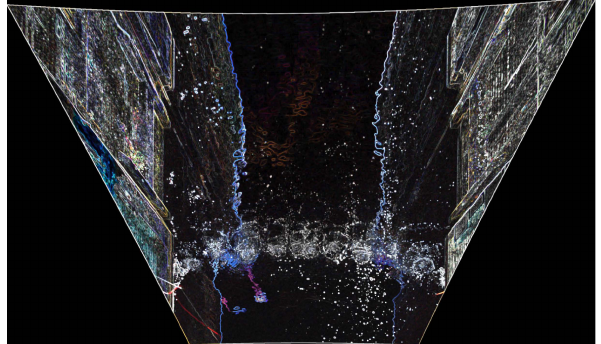
Fig. 10. Standard deviations in the color values of each pixel’s neighbouring